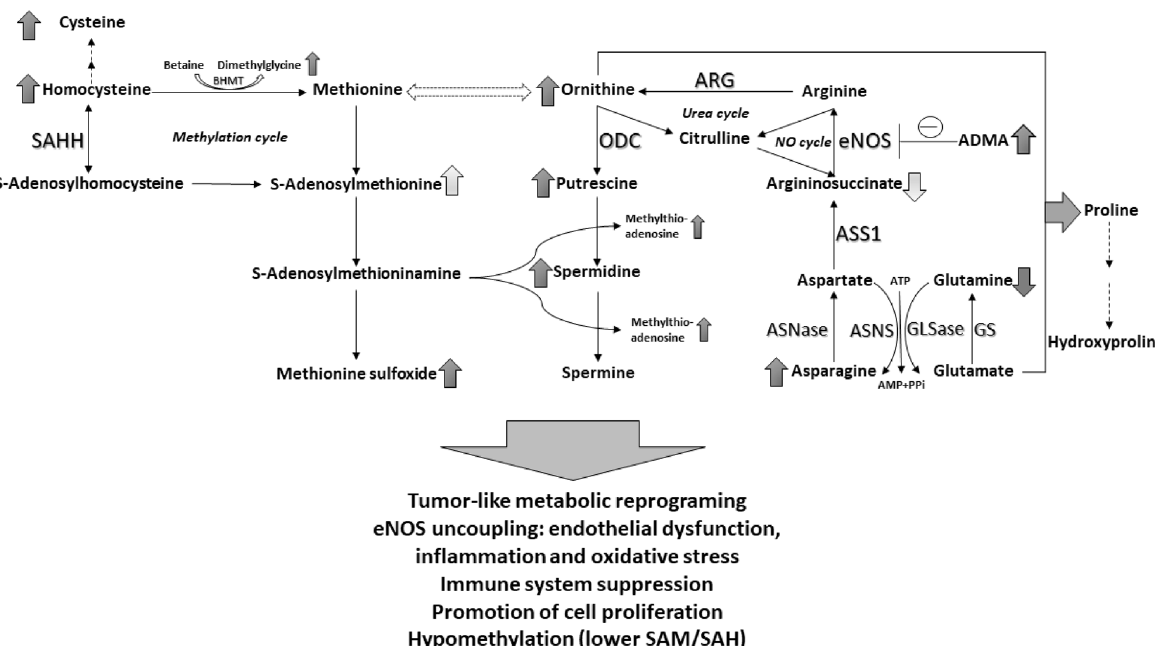
Figure 4. Summary of metabolic reprogramming observed in patients with ADPKD: changes in activity of NO and urea cycles, aspartate/asparagine and glutamine/glutamate cycles and methylation/ methionine cycles. Arrows indicate directional changes (increase/decrease) with lighter arrows expressing less pronounced changes. ADMA: asymmetric dimethylarginine, ARG: arginase1, ASNase: asparaginase, ASNS: asparagine synthetase, ASS1: argininosuccinate synthase 1, eNOS: endothelial nitric oxide synthase, GLSase: glutaminase, GS: glutamine synthetase, ODC: ornithine decarboxylase, SAM: S-adenosylmethionine, SAH: S-adenosylhomocysteine, SAHH: S-adenosylhomocysteine